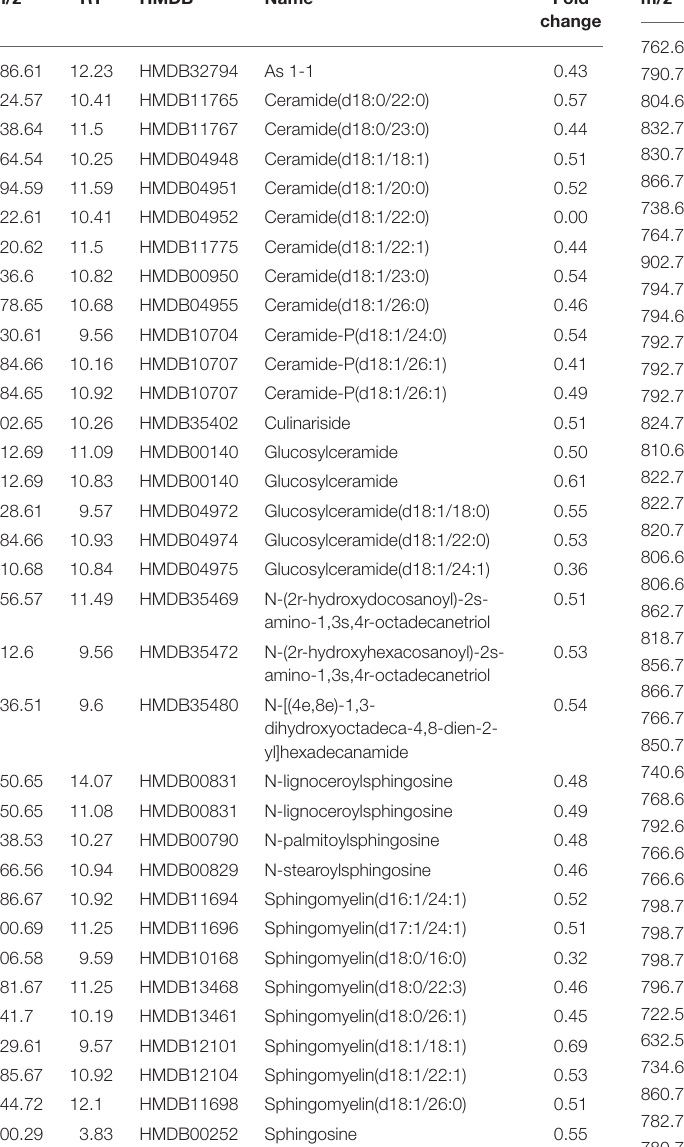
TABLE 2 | Dysregulation of sphingolipid metabolites in the spinal cord of SOD1 G86R mice, after positive ionization , and tentative identification. m/z